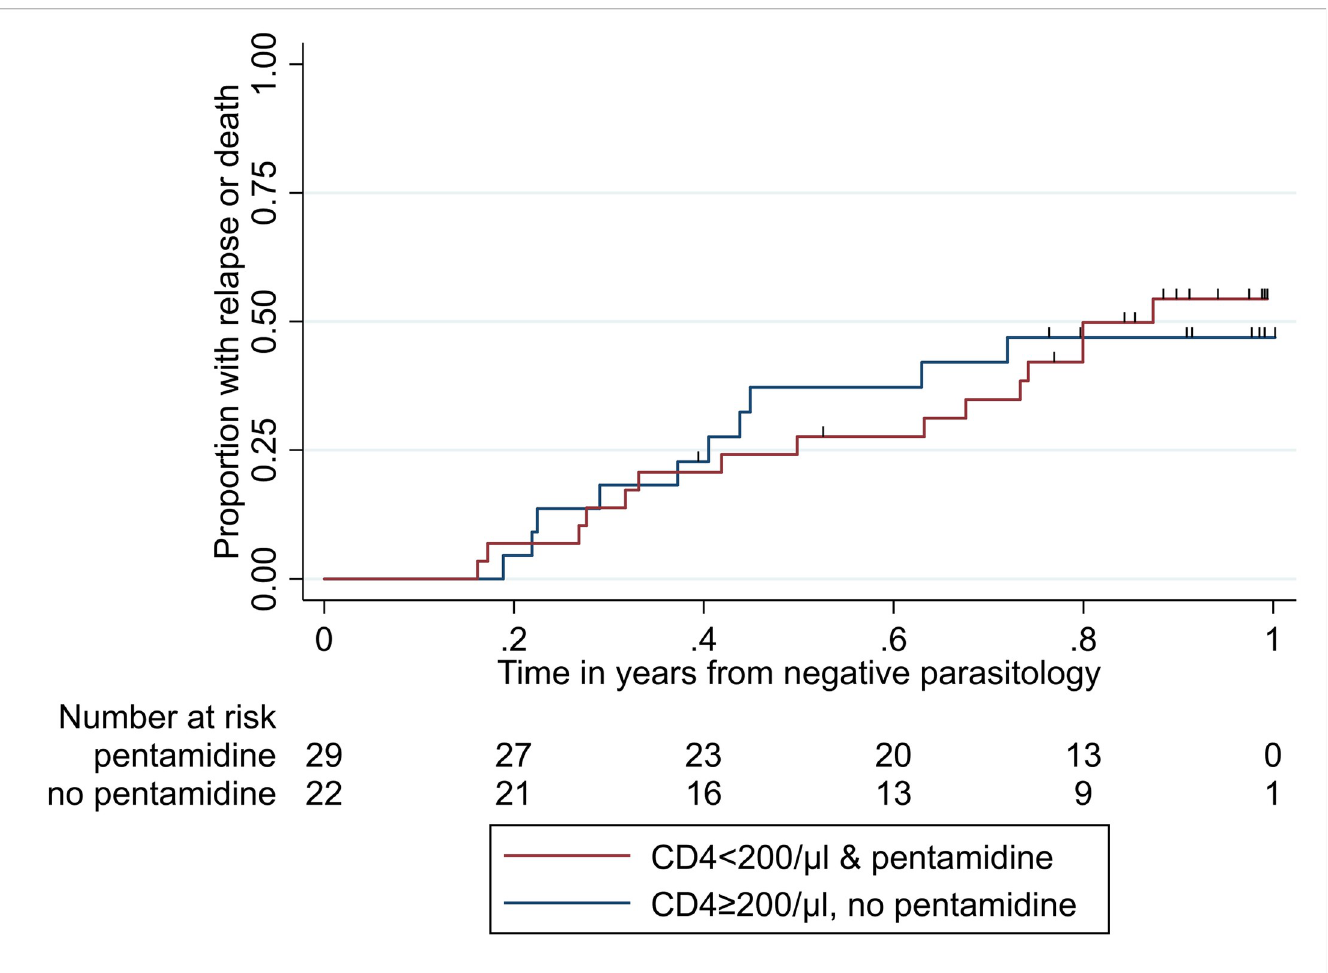
Fig 2. Kaplan-Meier curve for relapse or death, for the two groups shown in Table 3: a) CD4 < 200 cells/ μ L cells and pentamidine; and b) CD4 � 200 cells/ μ L cells without pentamidine. Overall, the median follow-up time was 0.77 years (9.2 months, range: 0.16–1.00 years). Median (range) follow-up time; CD4 < 200 cells/ μ L &